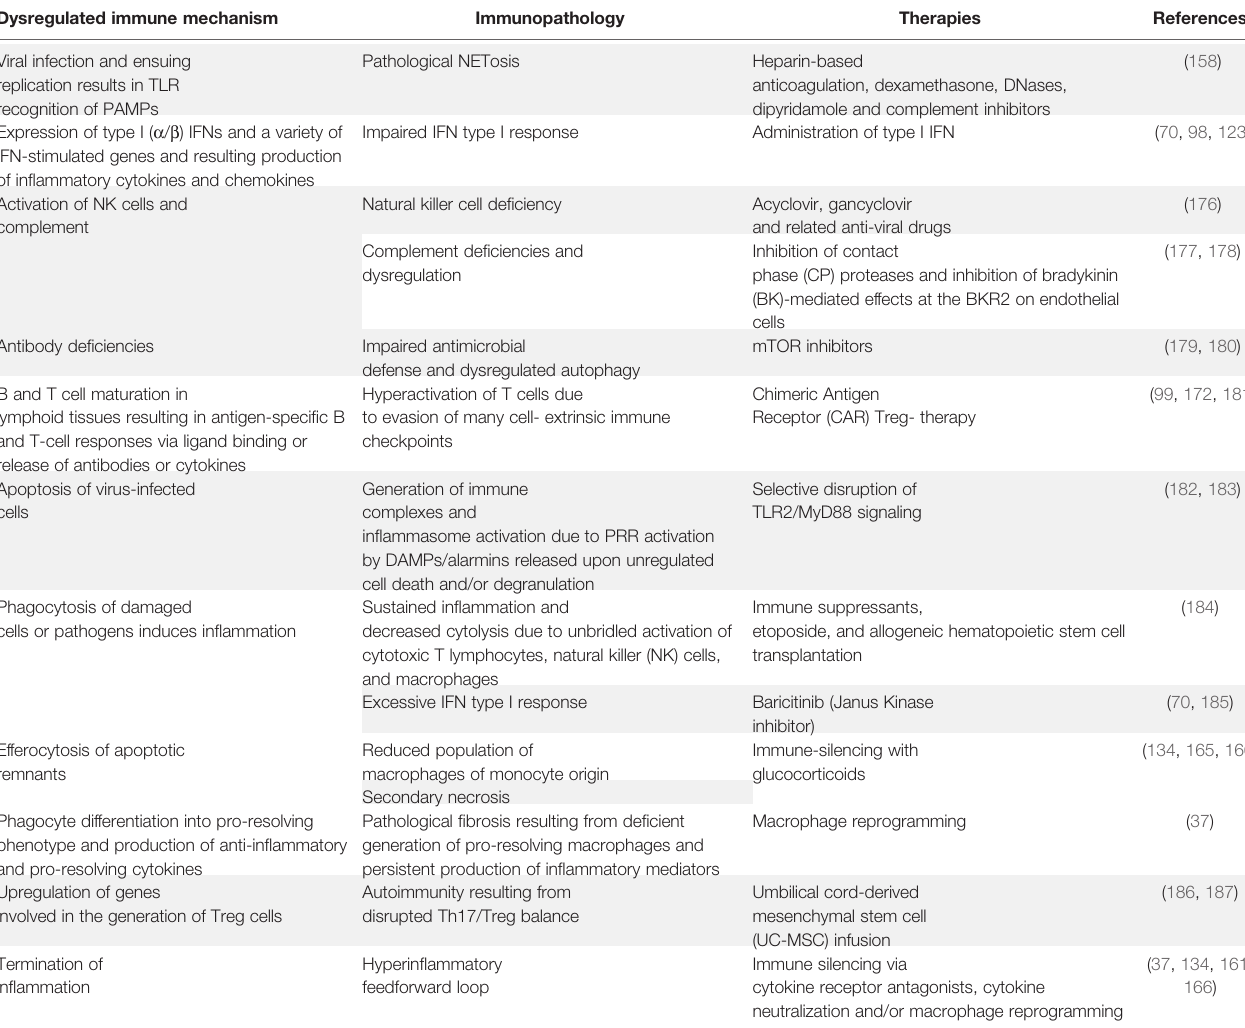
TABLE 2 | Dysregulated immunity-associated pathologies and potential corrective